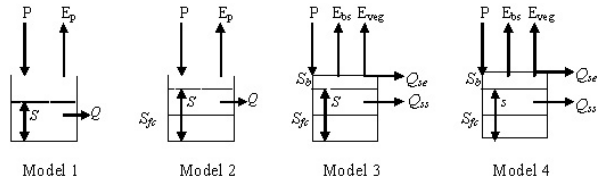
Fig. 2. Bucket configurations for Models 1, 2, 3 and 4. The differ- ence between Models 3 and 4 is the nonlinearity of Q ss in Model 4 (Eq.